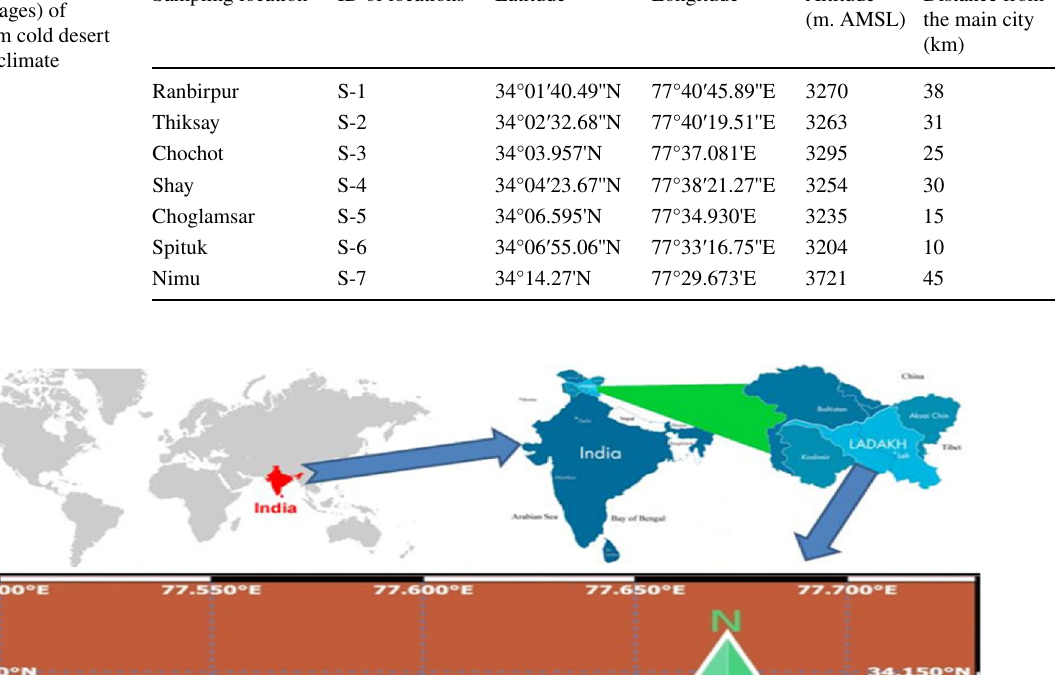
Sampling location ID of locations